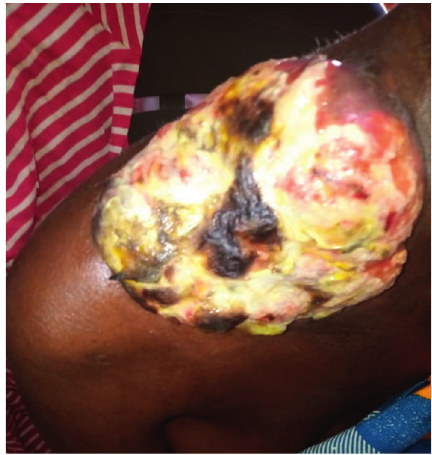
Figure 3: Extensive ulceration of neck mass while a diagnosis is awaited.